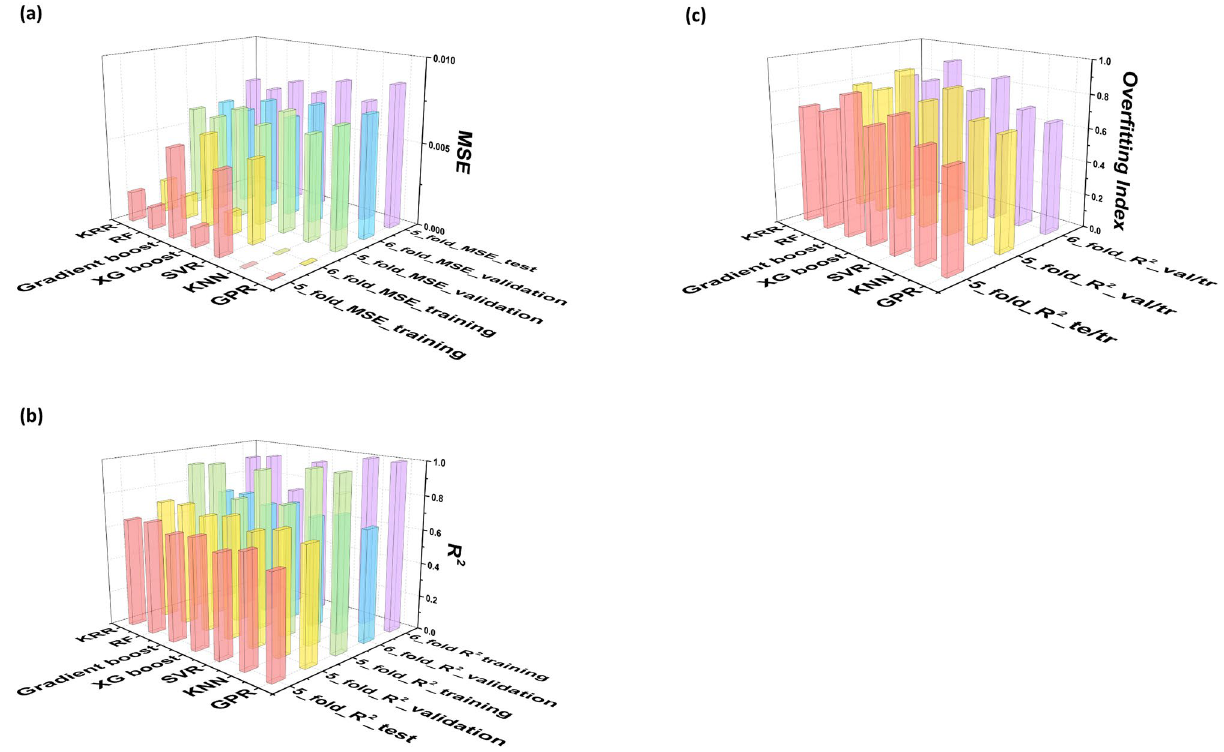
Figure 1. The training, validation and hold-out dataset test results for the seven non-linear ML algorithms in terms of ( a ) MSE and ( b ) R 2 for 6- and 5-fold cross validation with a holdout dataset test, ( c ) the over-fitting index defined as Validation_R 2 /Training_R 2 and Test_R 2 /Training_R 2